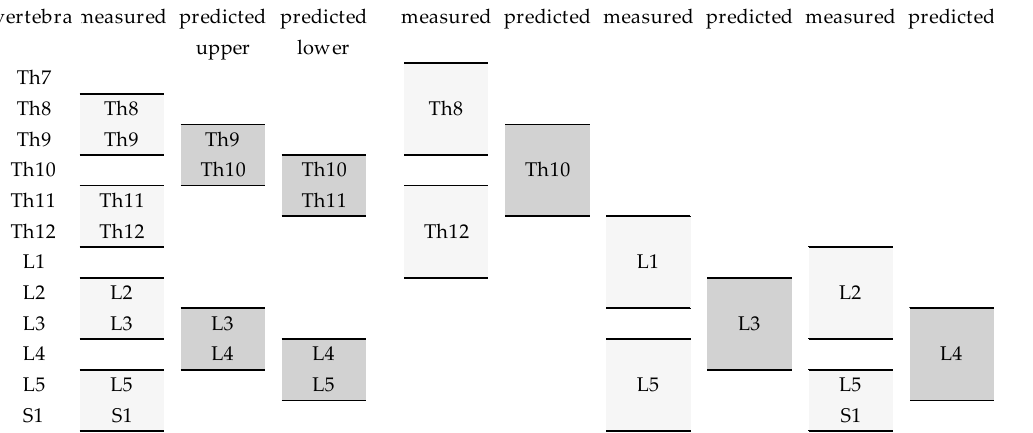
Figure 2. Schematic and exemplary representation of the measured (light grey) and the predicted (dark gray) monosegmental (mEPA) and bisegmental endplate angles (bEPA). The EPAs were measured as the enclosing angles of the cranial endplate of the cranial vertebra and the caudal endplate of the caudal vertebra. With one exception at S1 (first vertebra of the sacrum), here the cranial endplate was used as the caudal end of the EPA. The further cranial and caudal EPAs are shown as examples. The setup was chosen to predict the EPA in fractures of single vertebrae from Th10 to L4. The second example for bEPA, predicting L3, uses the bEPA of L1 and the EPA of the cranial endplates of L4 and S1. Predicting the bEPA of L4, the bEPA of L2 and the EPA of the cranial endplates of L5 and S1 were used.